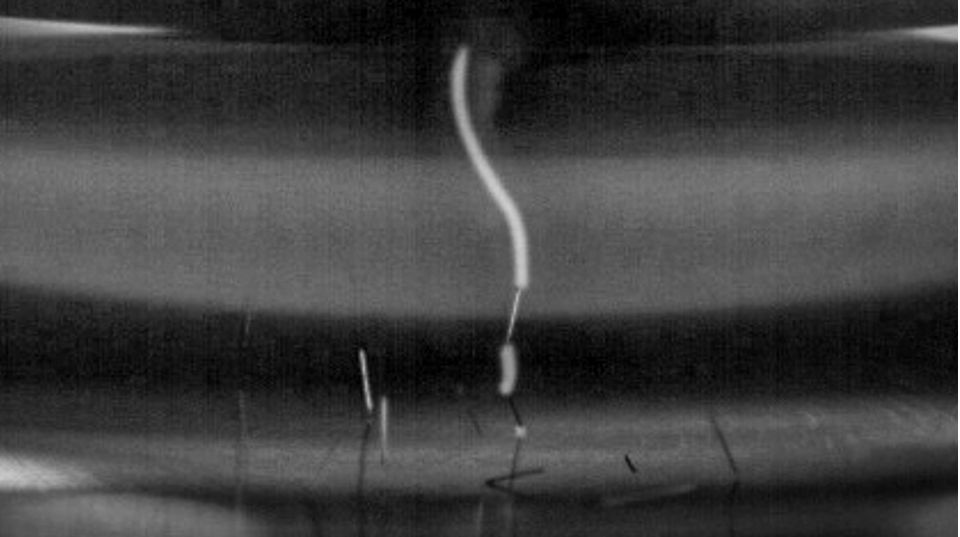
Figure 2. Picture of a breakdown in set-up 1 with 10 particles (0.75 MPa CO 2 /O 2 ). Three particles were involved in the breakdown.